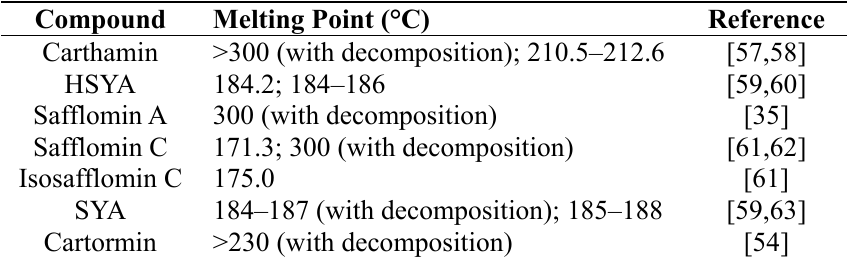
Table 3. Melting points of quinochalcone C